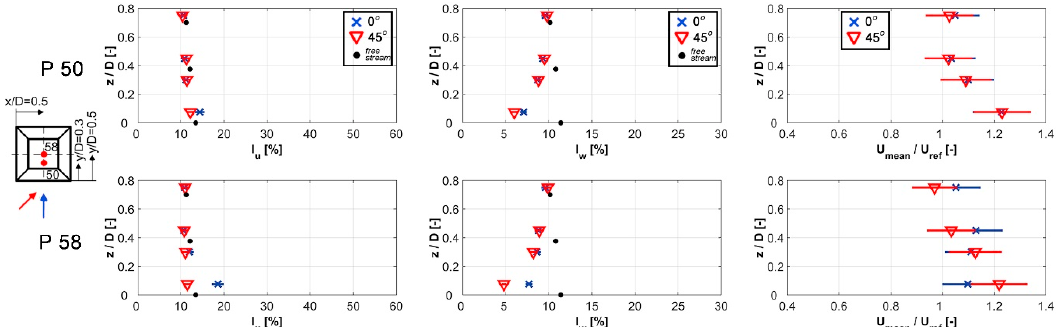
Figure 12. Profiles of stream-wise ( I U ) and vertical ( I W ) turbulence intensities (with the reference profile from the free-stream, values marked with black circles), and normalised stream-wise velocity U mean /U ref , with uncertainty limits, measured over the deck roof for two different wind angles of 0° and 45°, above points 50 and 58 ( x/D = 0.5).